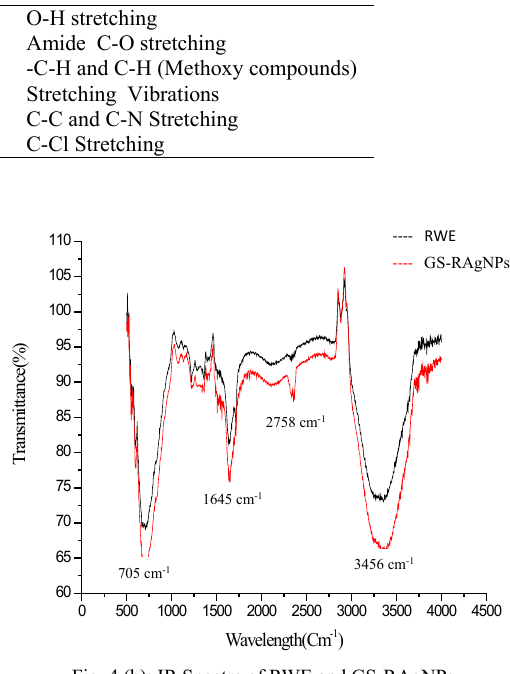
Table No. 2. IR Frequency Band for GS-RAgNPs Table 2: IR Frequency Band for GS-RAgNPs Sr. No.